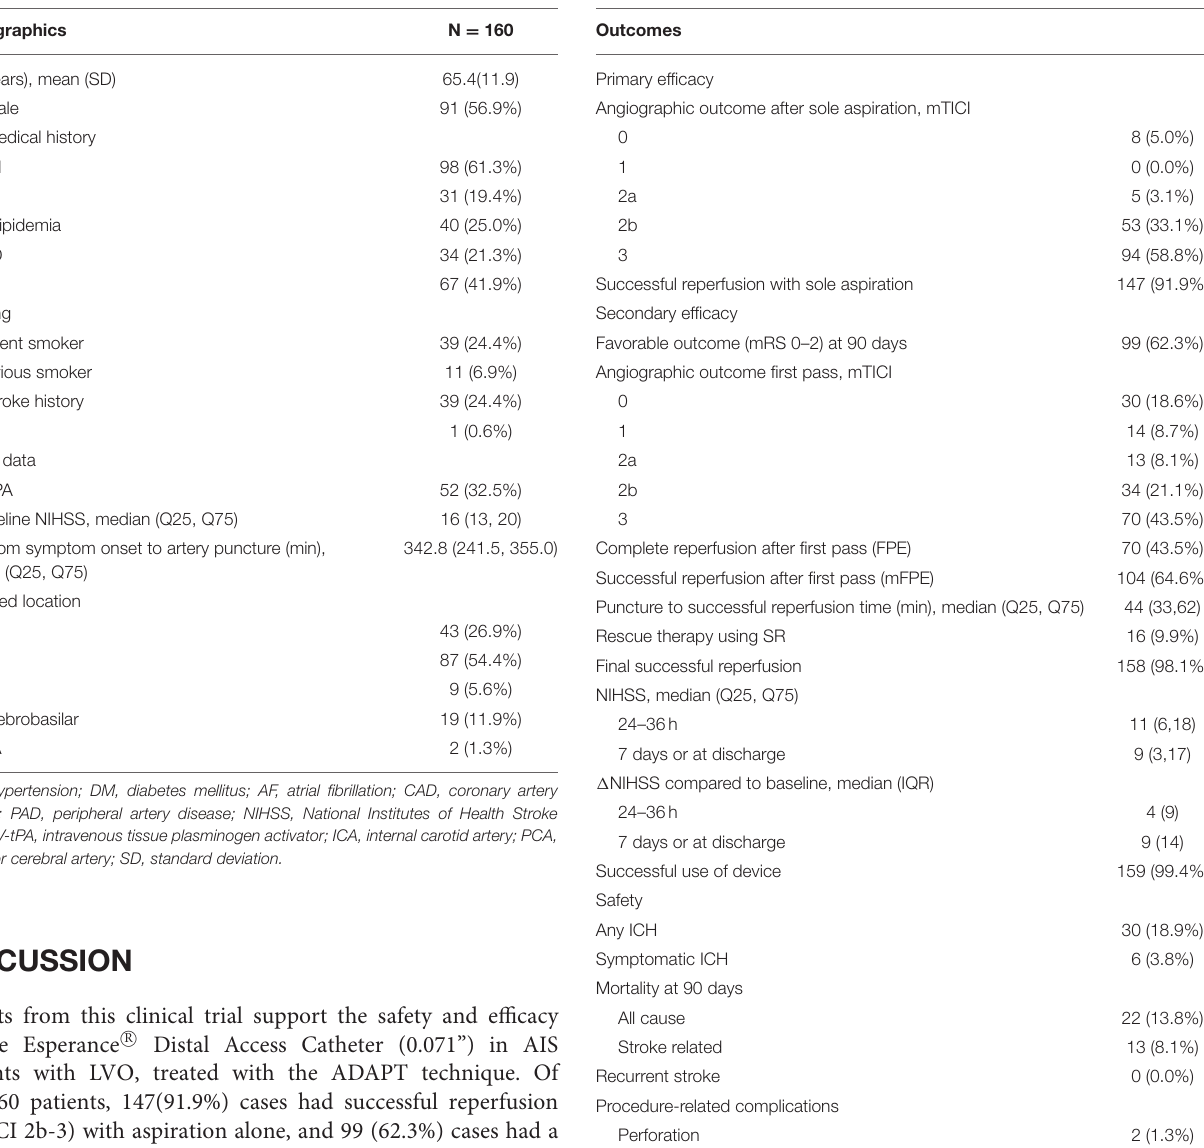
TABLE 1 | Demographic and baseline characteristics. TABLE 2 | Primary and secondary